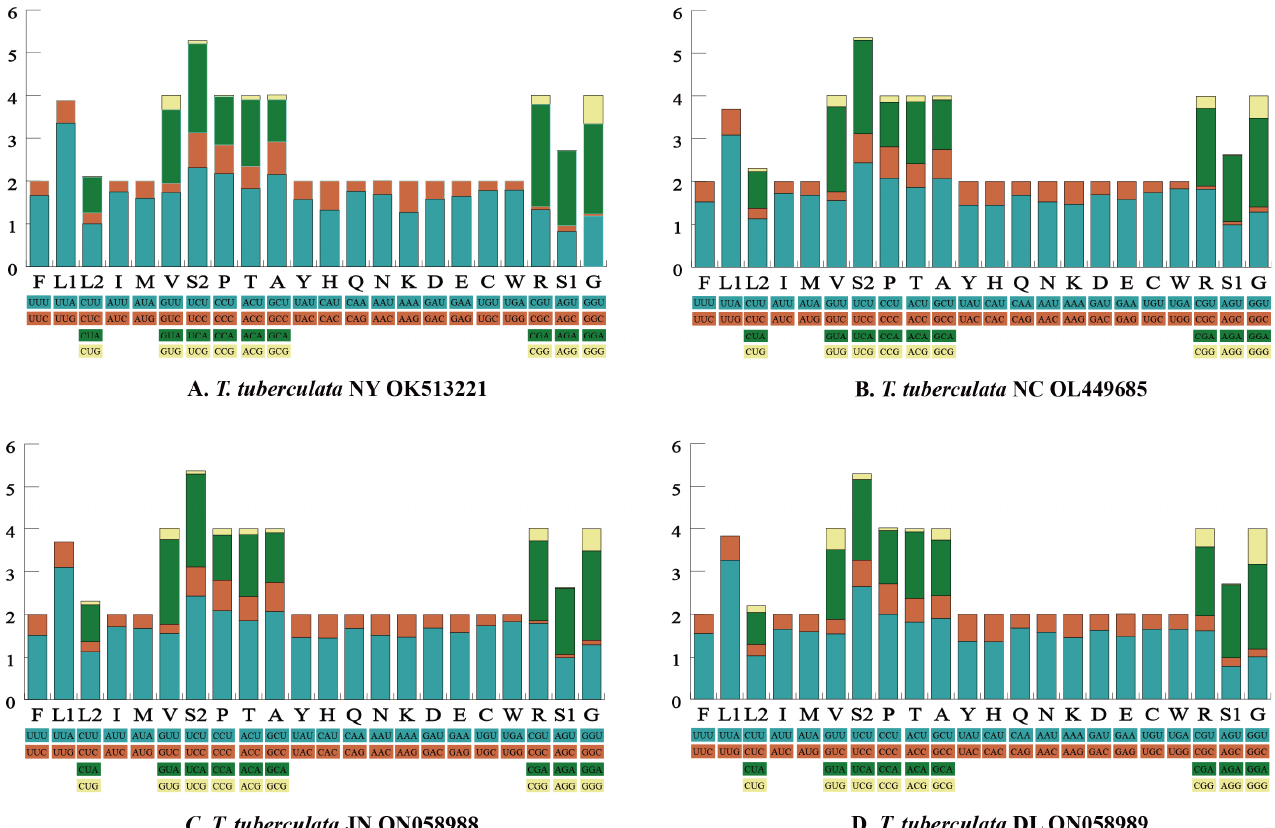
Figure 2. The relative synonymous codon usage (RSCU) of the 13 protein-coding genes. Codon families are provided on the x -axis along with the different combinations of synonymous codons that code for that amino acid. RSCU is defined on the y -axis.